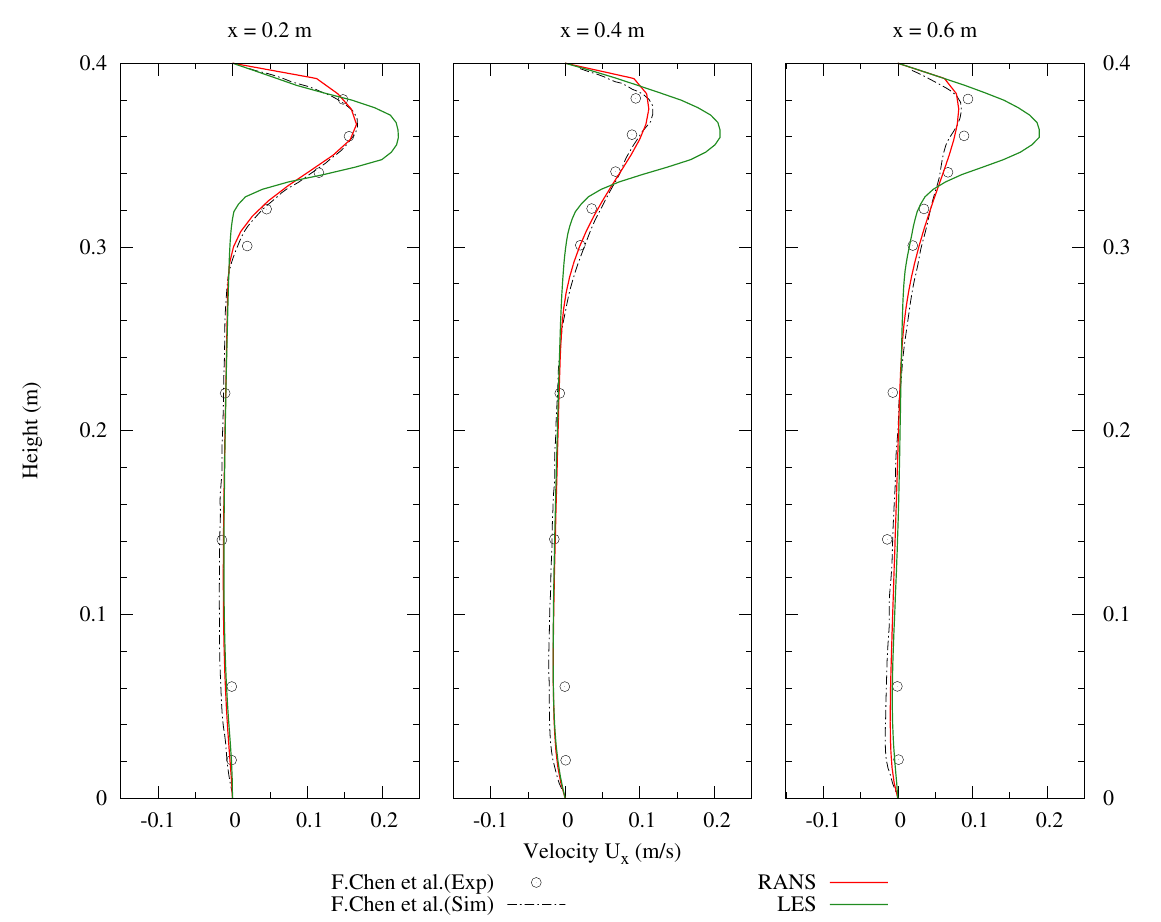
Figure 6. Comparison of the vertical profiles for the velocity in x-direction. Dots and dashed black lines were formed with data from the experiment of [42], Elsevier, 2006. Red lines are the simulated velocities from the RANS approach, green lines are the time-averaged results from the LES